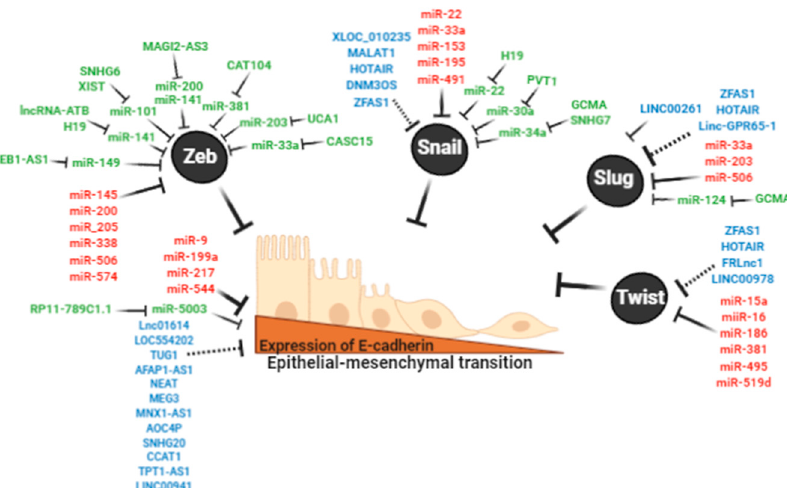
Figure 3. Non-coding RNA regulates the expression of E-cadherin and epithelial to mesenchymal transition (EMT)-inducing transcription factors (EMT-TFs). Black circles show EMT-TFs ZEB1 / 2, Snail, Slug, Twist that directly regulate E-cadherin. In red, miRNAs that directly bind CDH1 and EMT-TFs transcripts. In blue, lncRNA that directly bind CDH1 and EMT-TFs (AGAP2-AS1, HOTAIR, LINC00261) or dysregulate these transcripts through potential ceRNAs. In green, reported ceRNA networks to CDH1 and EMT-TFs transcripts.